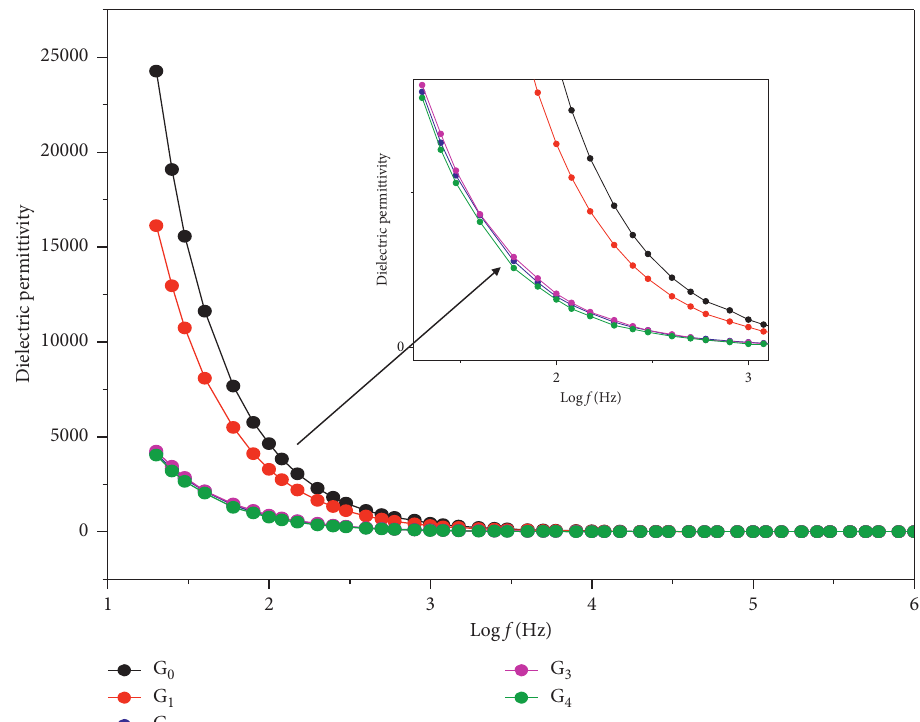
Figure 7: Real part of dielectric permittivity of geopolymer matrices cured at room temperature with different ratio between NaOH and KOH.